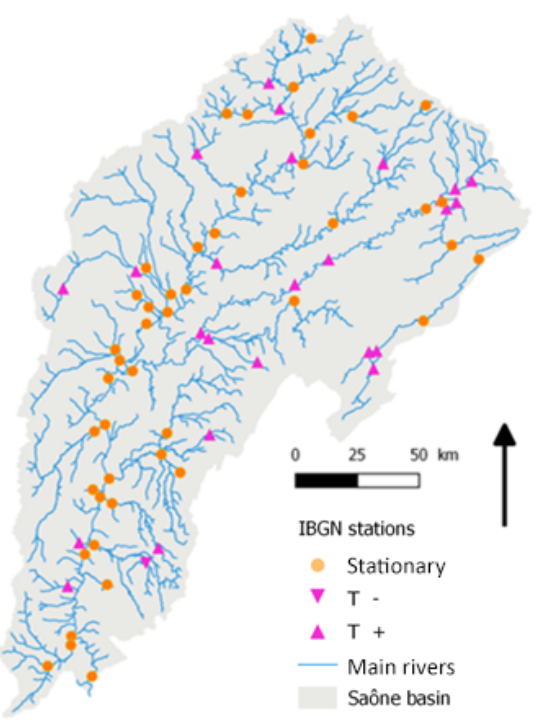
Figure 4. Detected trends for the 71 IBGN series (statistical tests plus FDR correction and graphical analysis). Stationary, T( + ), T( − ) stands for: stable, positive and negative trend